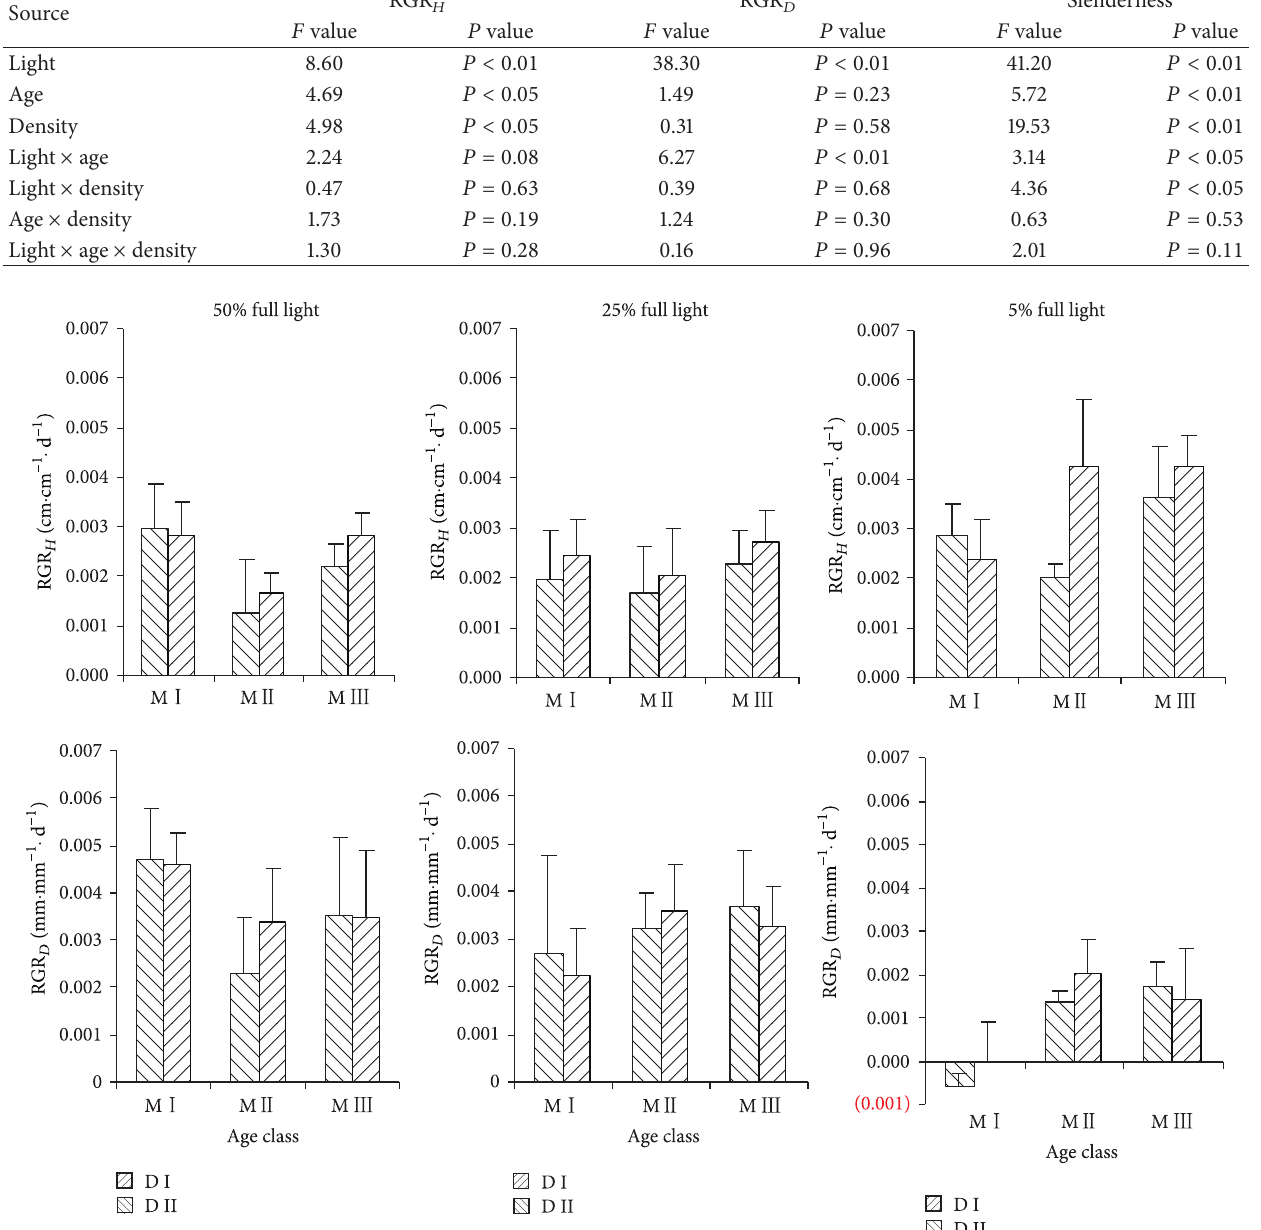
Table 3: Three-way ANOVA analyses of effects of light level, age, and stand density of mother tree age and their interactions on seedling growth for Pinus thunbergii.